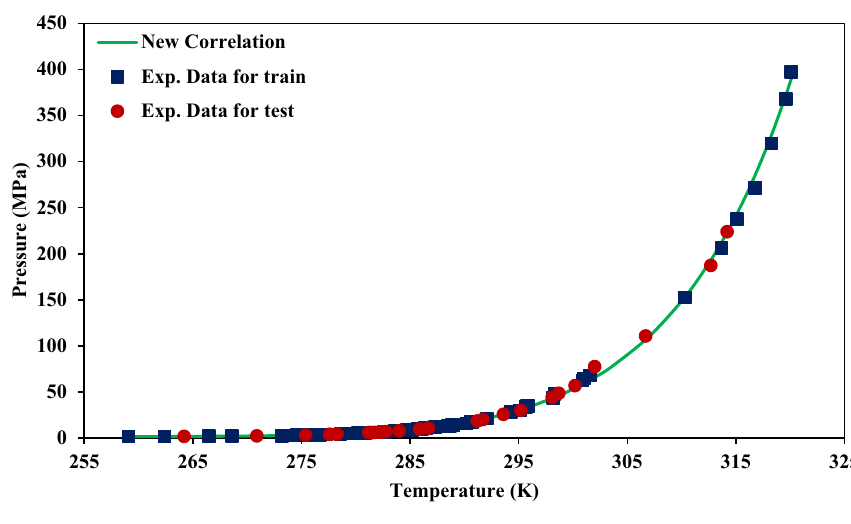
Fig. 7 Comparison between new correlation and experimen- tal